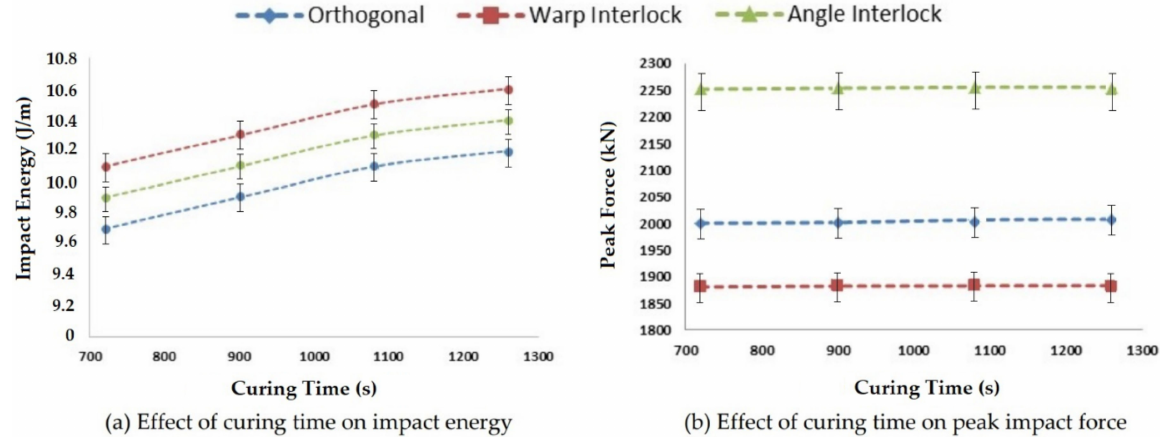
Figure 15. Effect of curing time on the impact properties of 3D woven composites.